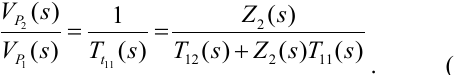
Figure 5: Reduced circuit equivalent to the system shown in Fig.